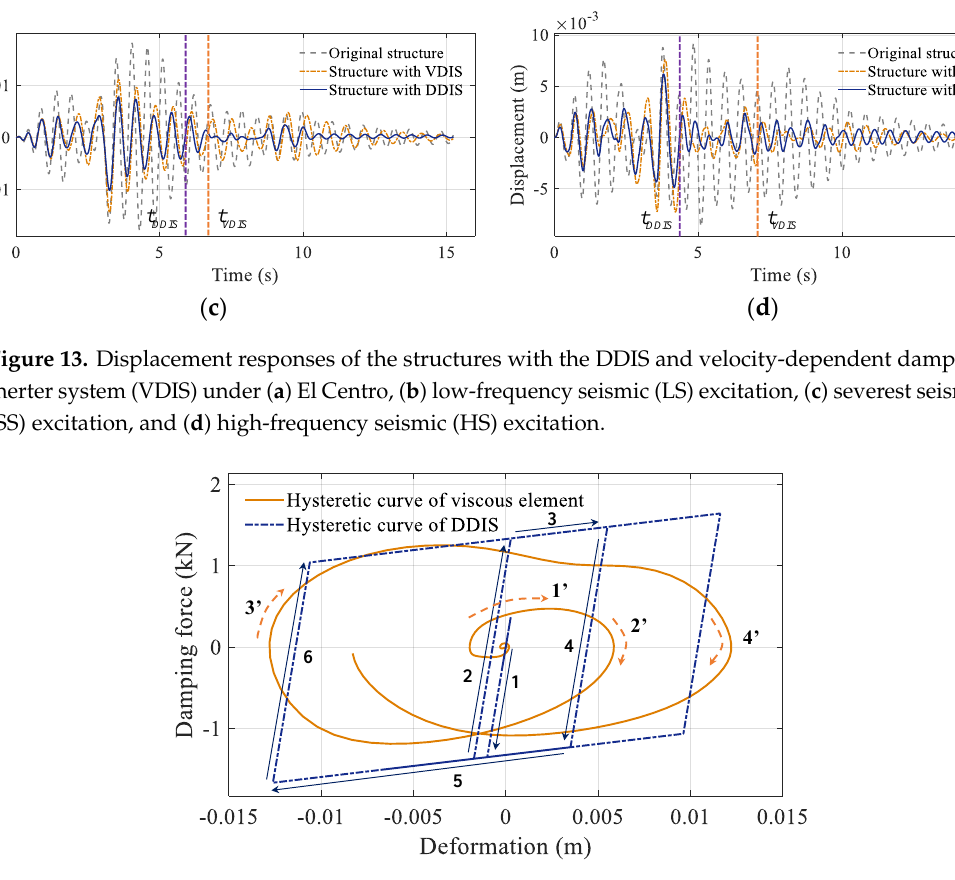
Figure 14. Hysteretic curve of DDIS and VDIS under El Centro in the early stage of the seismic response.